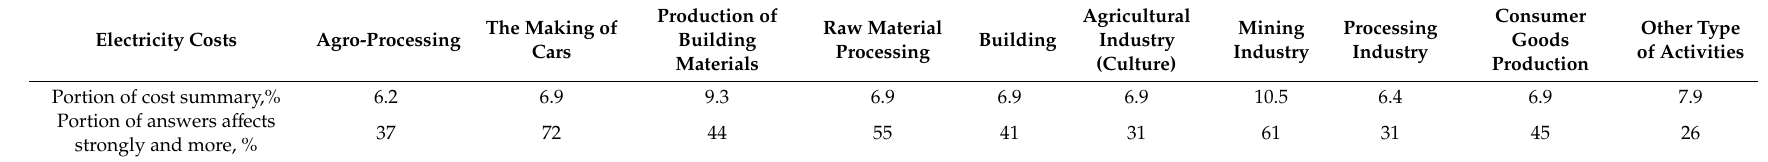
Table 4. Sectoral assessment of the level of impact of costs on electricity